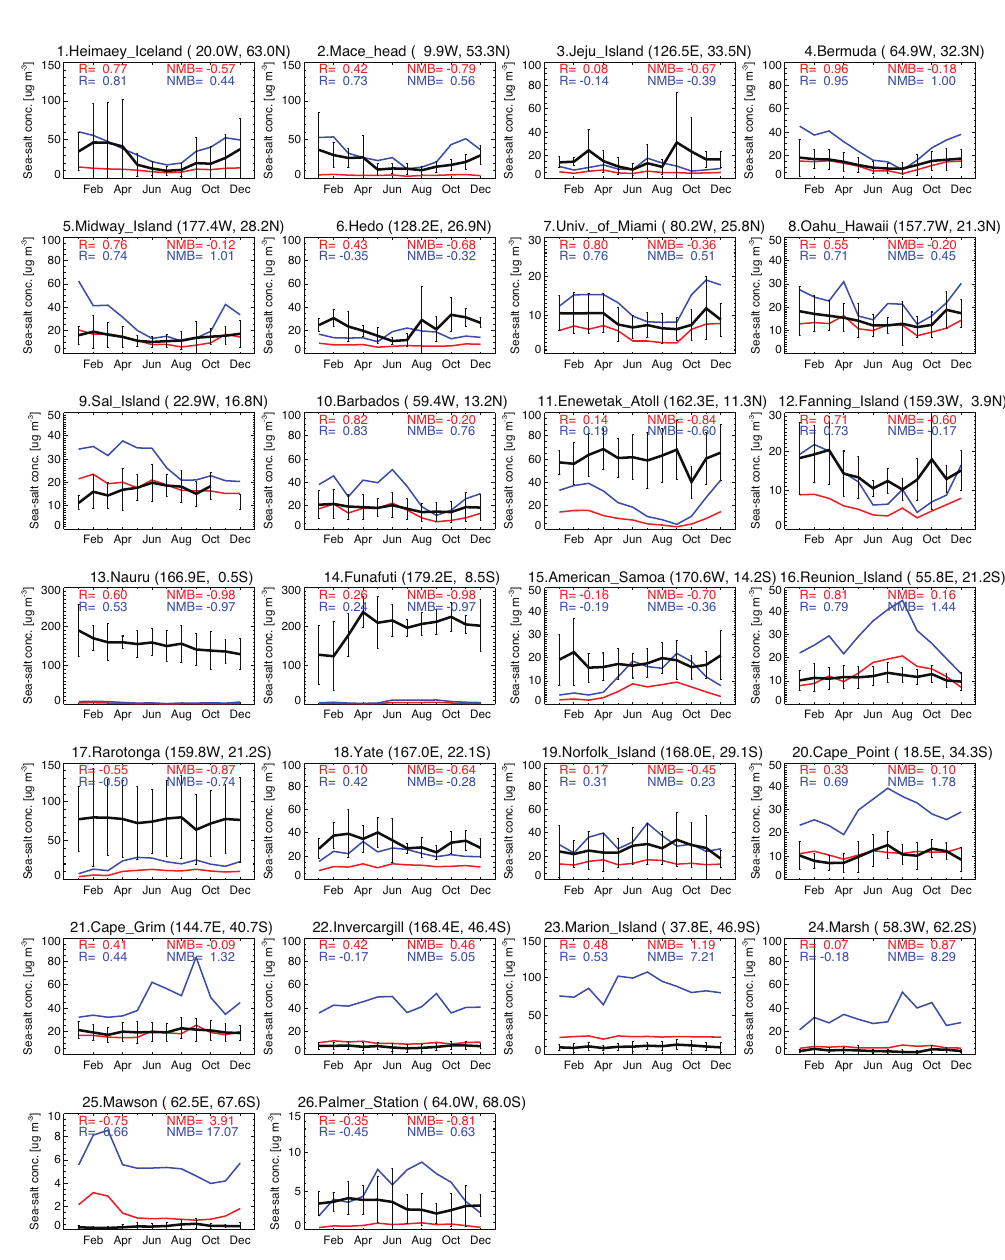
Figure 11. Same as Fig. 9 but for sea-salt mass